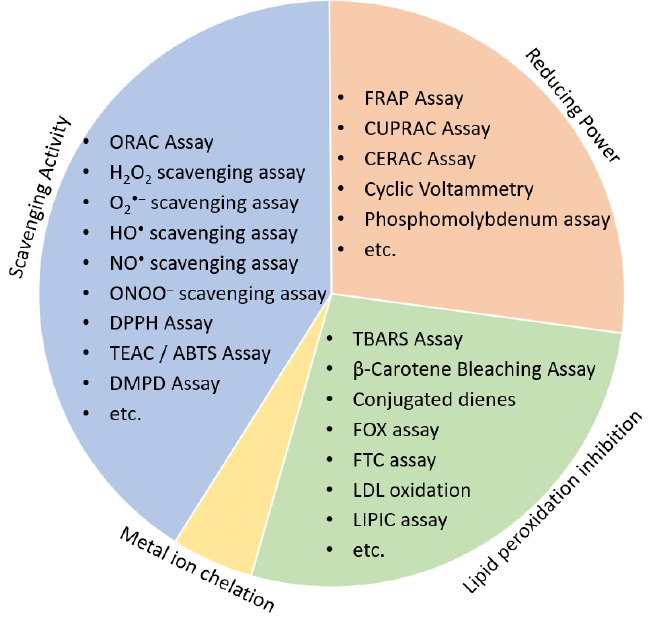
Figure 3. Antioxidant chemical-based assays divided based on the antioxidant activity to reducing power, lipid peroxidation inhibition, metal ion chelation and scavenging activity assay. Abbrevia-